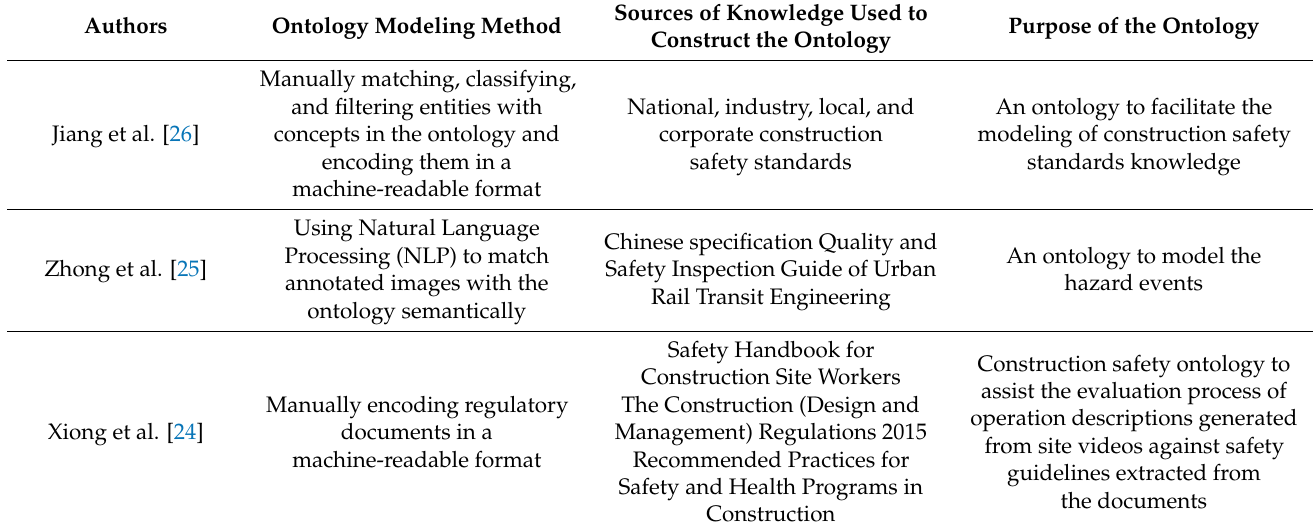
Table 1. Comparison of existing ontologies for construction safety management